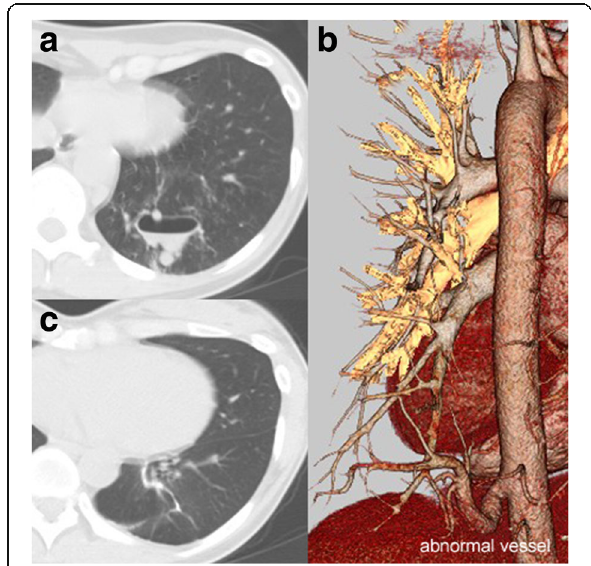
Fig. 1 CT images obtained before and after treatment. a Chest CT scan showing several cystic lesions with niveau formation and consolidation in left S10 without communication with the bronchus. b Three-dimensional CT scan showing an abnormal artery branching from the descending aorta and normal pulmonary vein. c Chest CT